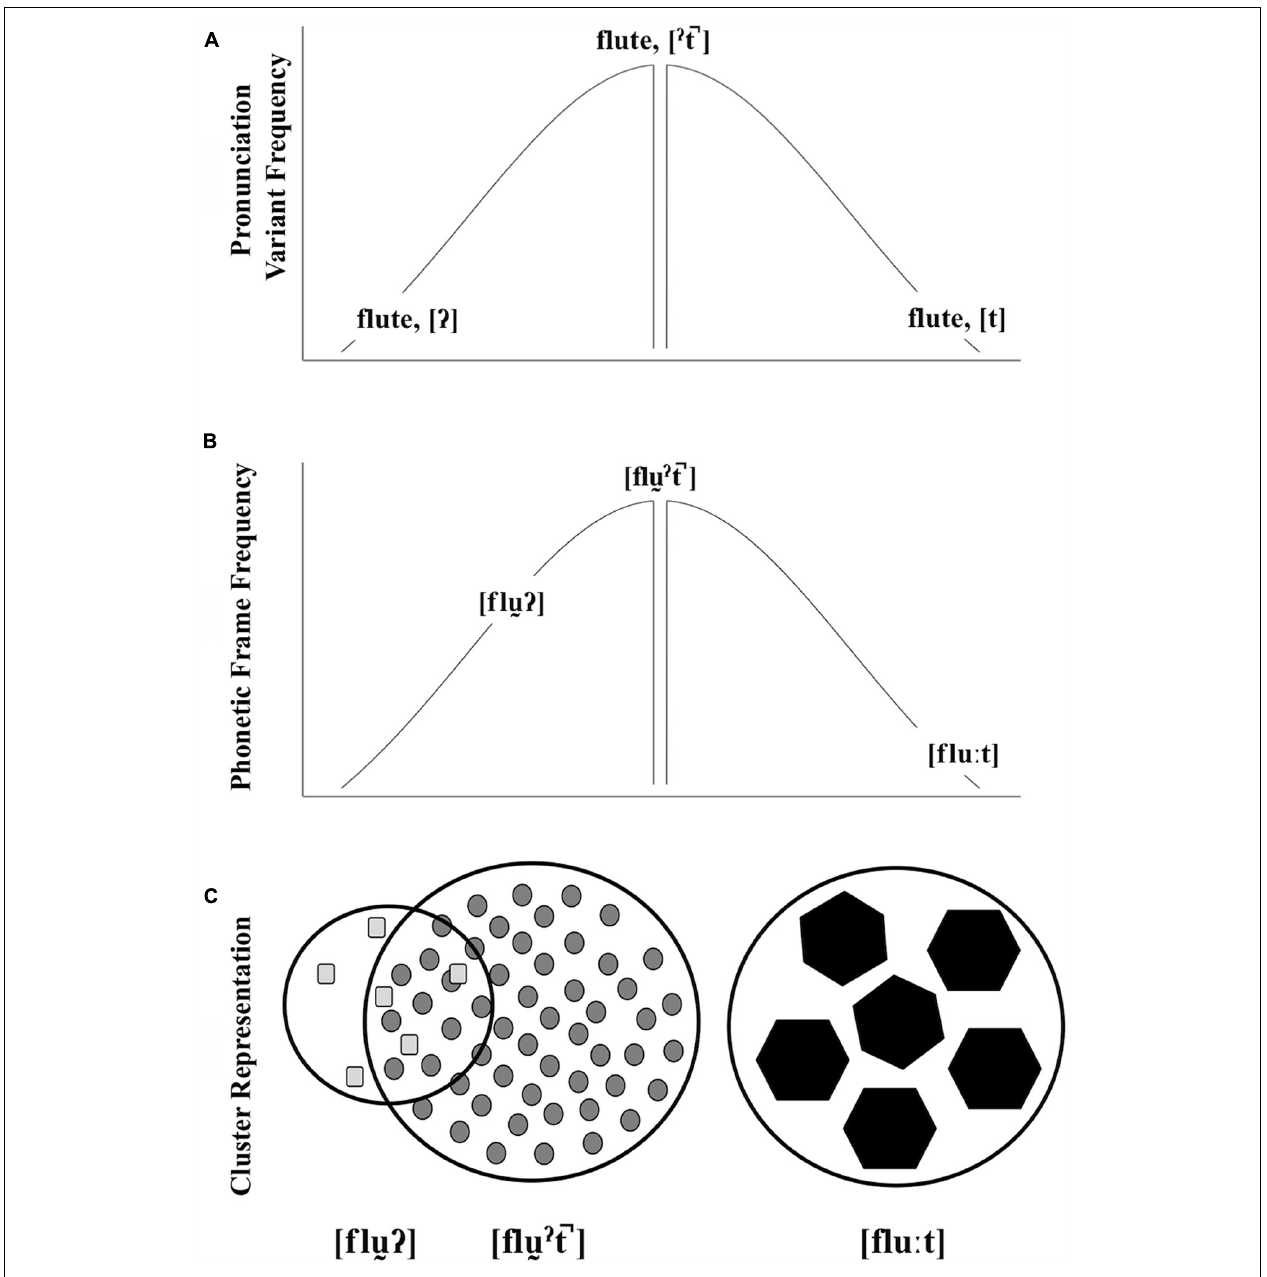
word-level phonetic variation. In our schematic, cluster representations, shape corresponds to pronunciation variant, cluster size corresponds to cluster robustness, and token size corresponds to encoding strength. The overlap between the atypical glottal-final form and the typical glottalized, unreleased-final form represent the typicality benefit applied to the atypical form.